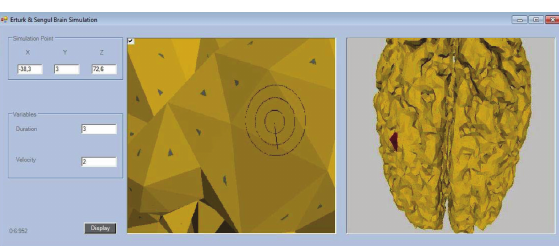
Figure 3: The simulation work that shows the propagation mechanism of the SCD. The central point shows the initiation point of the SCD, which is located on the occipital lobe of the brain. The gray small triangles show the electrical dipoles, and the brown lines show the propagated points of the SCD after 10 seconds,